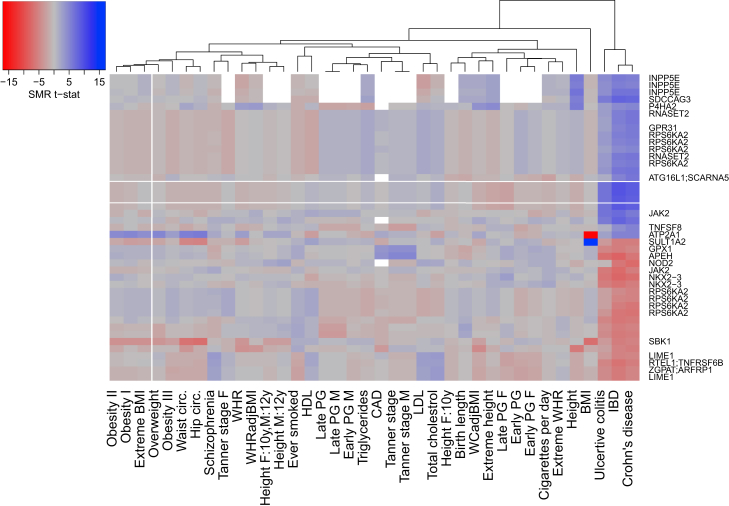
Heatmap of the SMR Results for 32 DNA Methylation Sites Associated with Crohn Disease across 38 GWAS DatasetsEach square in the heatmap represents the t-statistic (b_SMR/se_SMR) of the GWAS trait (columns) for a DNA methylation site (row; n = 32) associated with Crohn disease. Only phenotypes (n = 38) tested against at least 20,000 DNA methylation sites were included in this comparison. SMR p < 1.38 × 10−6 and HEIDI p > 0.05.